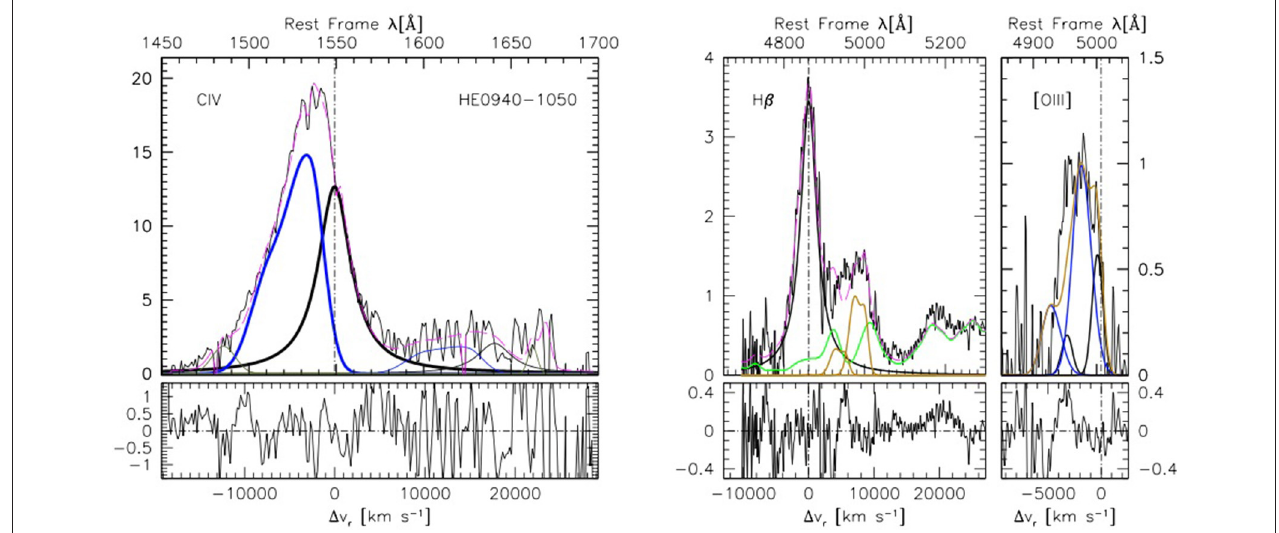
FIGURE 1 | (Left panel) CIV λ 1549 emission after continuum subtraction. A scaled H β profile is superimposed (adapted from Sulentic et al., 2017). (Right panel) H β spectral range. The green line shows the adopted FeII template. The full profiles of [OIII] λλ 4959,5007 are shown in orange. The thick black lines identify a symmetric unshifted emission that is dominating H β and still contributing to CIV λ 1549. The thick blue lines trace the excess emission once the symmetric component is subtracted. The thin lines in the CIV panel show the interpretation of the HeII λ 1640 profile assuming a symmetric and a blue shifted component, as for CIV. The rightmost panel provides an enlargement on the [OIII] λλ 4959,5007, semi-broad, boxy and blue-shifted profile (not a unique case at high L : e.g., Cano-Díaz et al., 2012 ). The [OIII] profile is modeled as the sum of a moderately blueshifted core component (black line) and of a semi-broad component, blue-shifted by